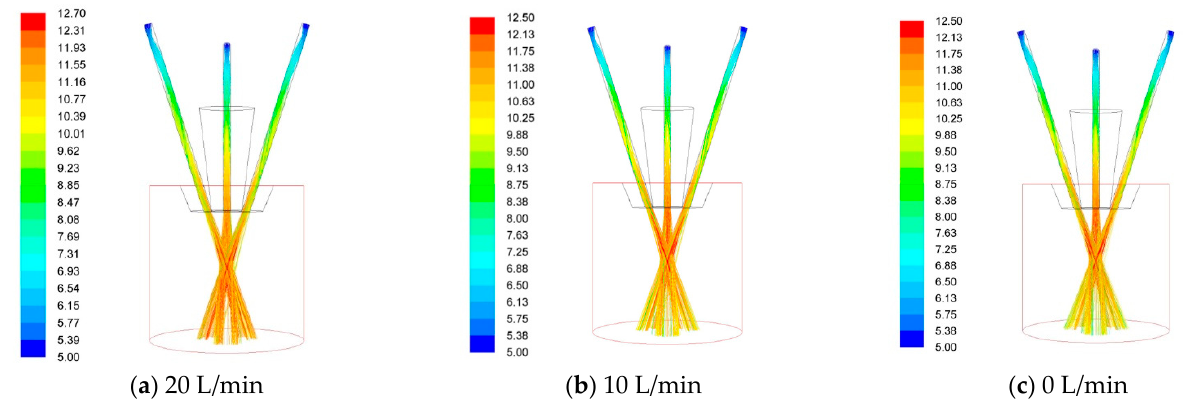
Figure 12. Influence of inner shielding gas on powder stream. ( a ) 20 L/min; ( b ) 10 L/min; ( c ) 0 L/min.